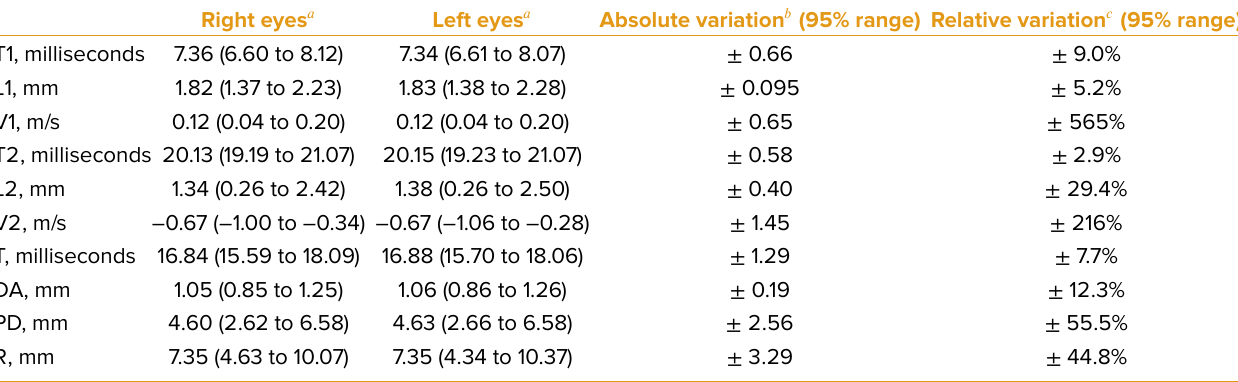
Table 2. Mean and normal range of Corvis parameters among participants